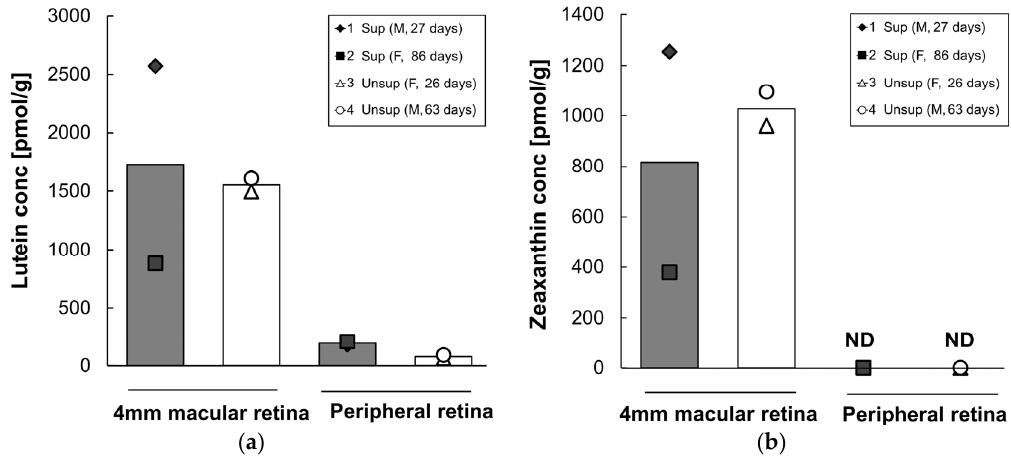
Figure 5. Lutein ( a ) and zeaxanthin ( b ) concentrations in each retina region of infant monkeys fed either supplemented formula ( n = 2) or unsupplemented formula ( n = 2) for 16 weeks. Each symbol represents individual animal; each column represents mean concentration of lutein of two animals. Solid column denotes supplemented formula (Sup) while open column denotes unsupplemented formula (Unsup). ND: not detected.